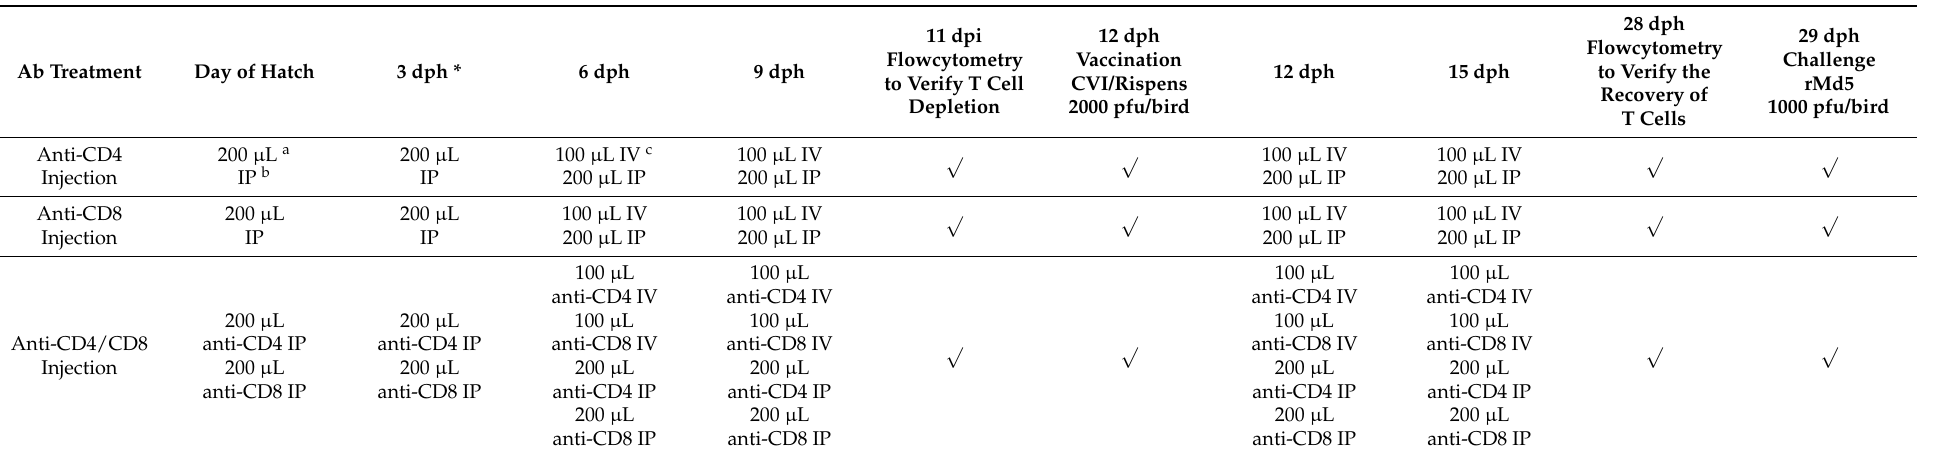
Table 2. Anti-chicken CD4 and CD8 treatment